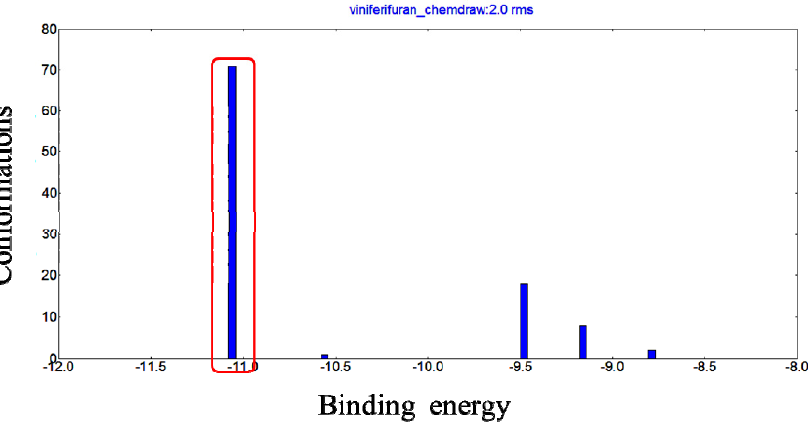
Figure 9. Conformational clusters of viniferifuran–XO (PDB ID: 1N5X) from 100 docking runs.